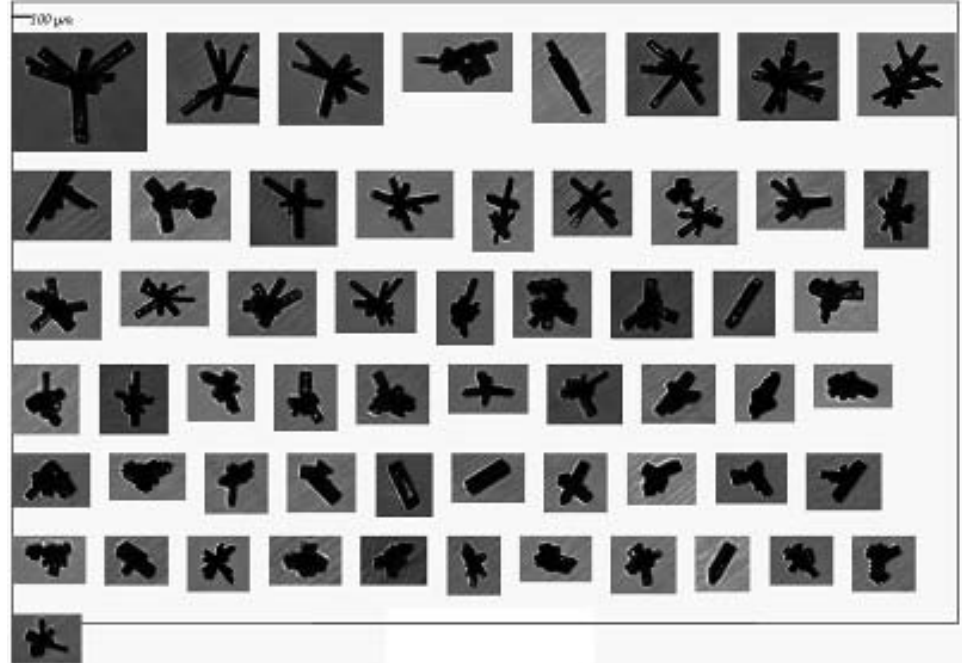
Fig. 11. Ice crystal habits observed in high-level frontal Ci, at temperatures T < − 40 ◦ C, over Adelaide, Australia, during the EMERALD-I experiment, Gallagher et al. (2005a). Habits presented as mainly pristine bullet